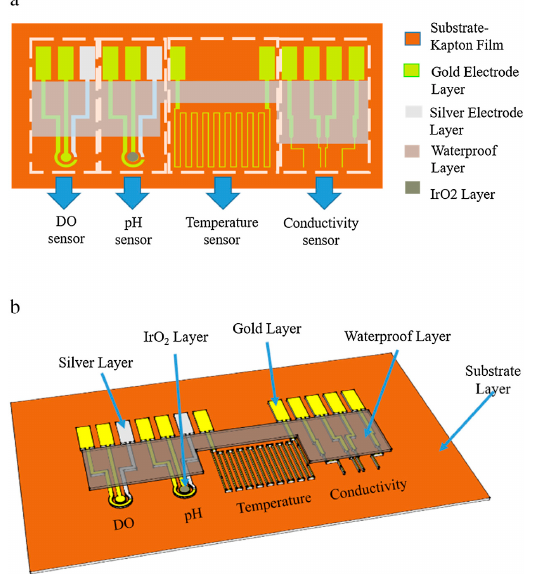
Figure 1. Image of dissolved oxygen (DO), pH, temperature, and conductivity MEA sensors ( a ) and layers on each MEA sensor ( b ). Reprinted with permission from Ref. [21]. (Copyright, 2016, Else- vier).